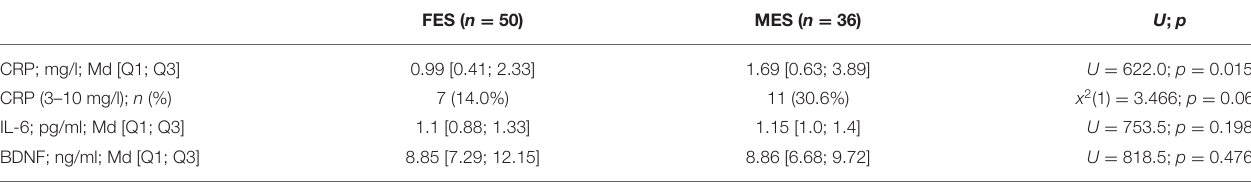
TABLE 5 | Laboratory tests results in FES and MES patients.